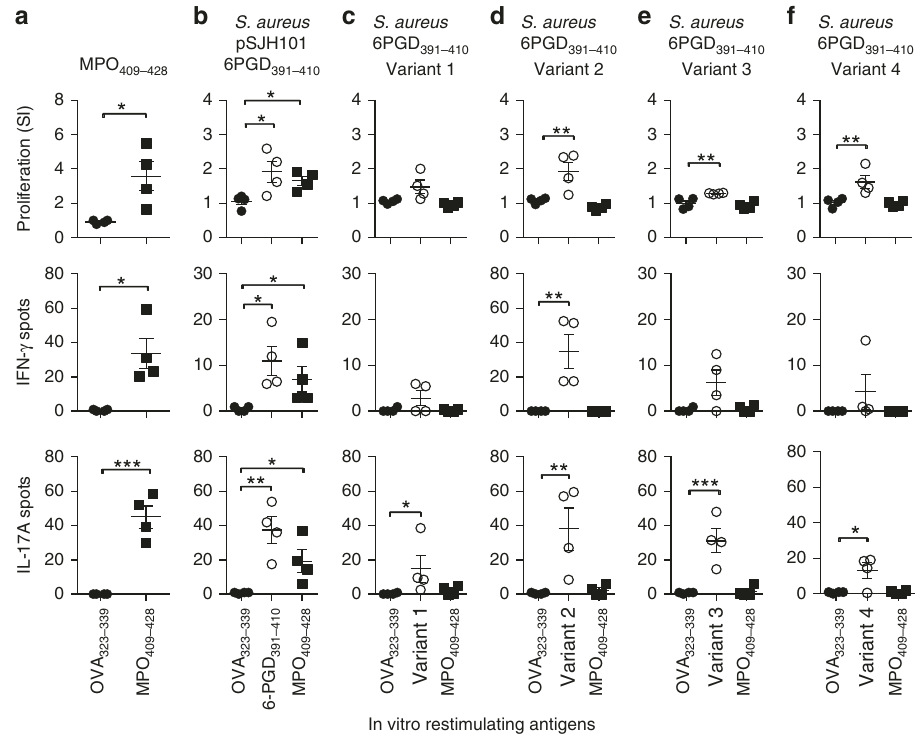
Fig. 5 Anti-MPO T-cell responses after immunization S. aureus- derived 6PGD 391 – 410 sequences. C57BL/6 mice ( n = 4 each group) were immunized with either a MPO 409 – 428 (positive control), b pSJH101-derived 6PGD 391 – 410 (YFKNIVTDYQEALRDVVATG), c S. aureus 6PGD 391 – 410 Variant 1 (YFKNIVTDYQDALRDVVATG), d S. aureus 6PGD 391 – 410 Variant 2 (YFKNIVTNYQEALRDVVATG), e S. aureus 6PGD 391 – 410 Variant 3 (YFKNIVTEYQDALRDVVATG), f S. aureus 6PGD 391 – 410 Variant 4 (YFKNIVTNYQDALRDVVATG). T-cell recall responses were measured ex vivo to either OVA 323 – 339 , the immunizing peptide, or MPO 409 – 428 using [ 3 H]-thymidine proliferation assays (top row), and ELISPOT IFN- γ (middle row) or IL-17A (bottom row). Each dot represents the response from an individual mouse, error bars represent the mean ± s.e.m. Data are representative of two independent experiments. * P < 0.05, ** P < 0.01, *** P < 0.001 by Kruskal – Wallis test. Source data are provided as a Source Data fi